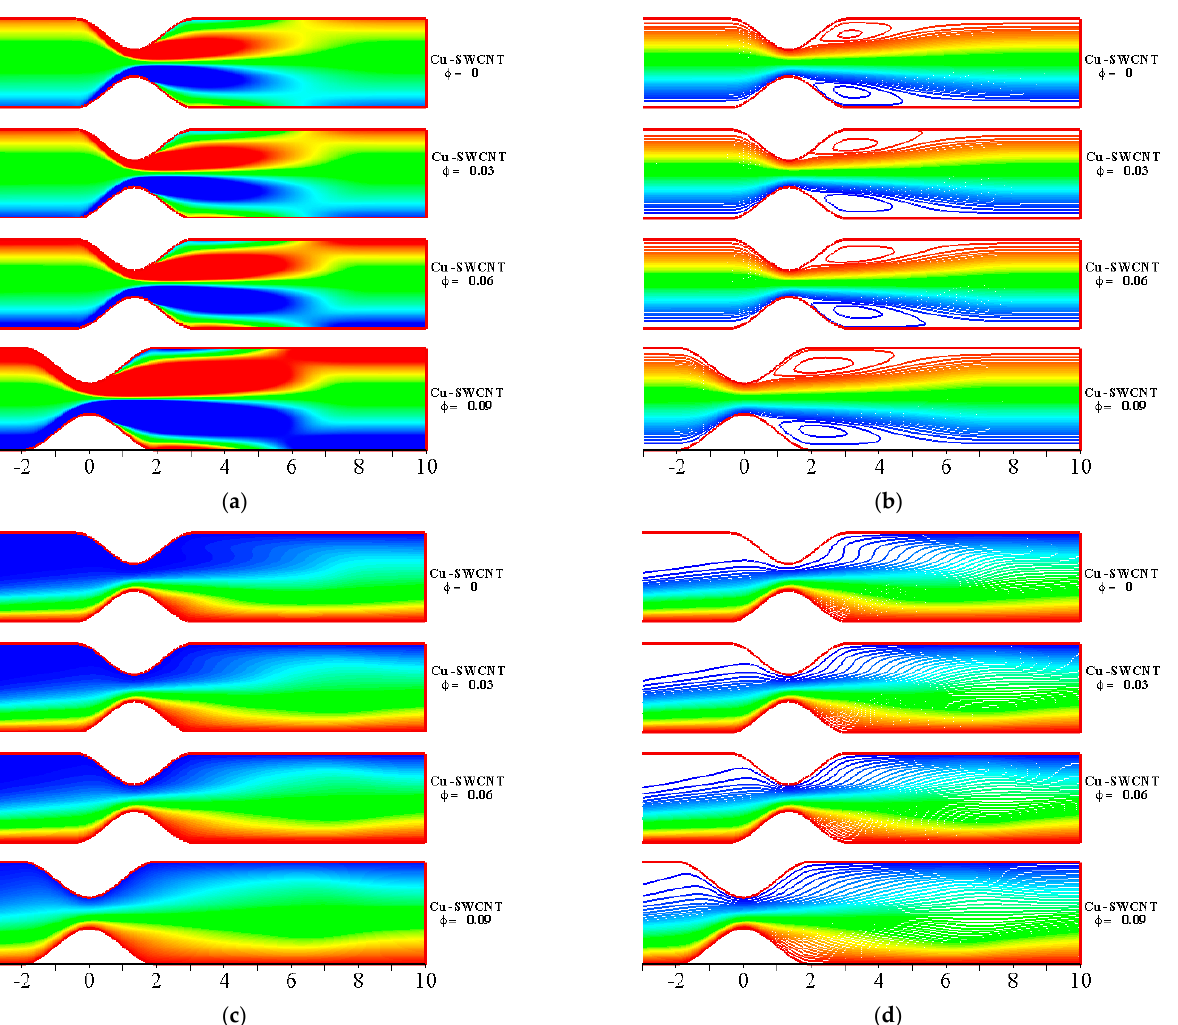
( d ) Figure 16. Impact of ( a ) 𝑀 , ( b ) 𝛽 , ( c ) 𝐷 (cid:3028) , and ( d ) 𝑅𝑒 on 𝑆𝑘 . The Nusselt number grows as the flow becomes more turbulent due to the rising number of collisions among the fluid particles. Since more viscous fluids have a lower Reynolds number, less heat transfer occurs, lowering the Nusselt number. The Nusselt number grows as 𝛽 estimations intensify. The streamlines, vorticity, temperature distribution, and concentration plots with 𝑀 = 5 , 𝑆𝑡 = 0.02 , 𝑅𝑑 = 0.2 , and 𝑅𝑒 = 800 are shown in Figure 17 for Cu-SWCNT-based HNF. The formation of vertical eddies in the vicinity of the walls can be observed. The eddies increase for the HNF and slowly occupy a major part of the channel downstream of the constriction. The inclusion of multiple types of NPs adds more energy. This results